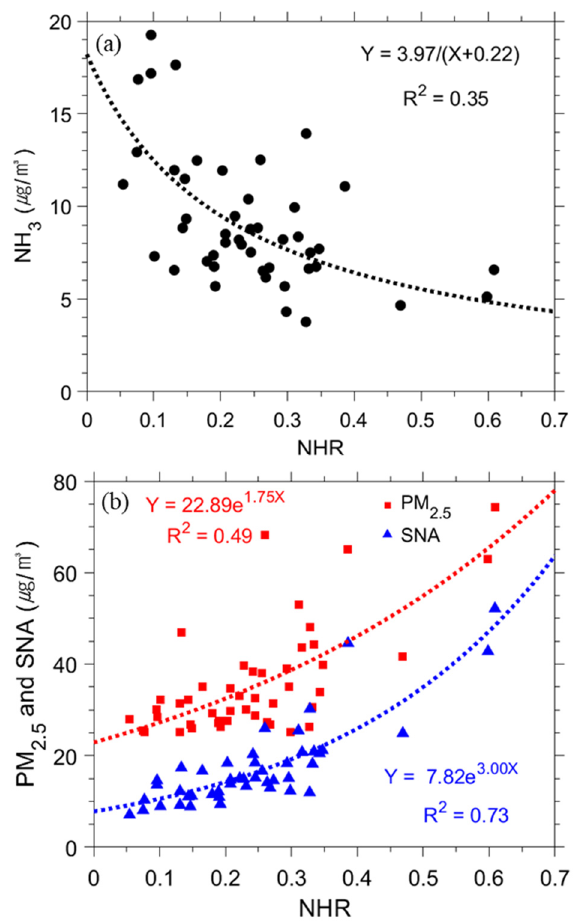
Figure 6. Relationship between the daily average ratio of NH 4+ to total NH 3 (NHR) and ( a ) NH 3 concentrations, and ( b ) daily average PM 2.5 and SO 42 − , NO 3 − , and NH 4+ (SNA) concentrations during PM 2.5 pollution days (PM 2.5 ≥ 25 μ g/m 3 ).